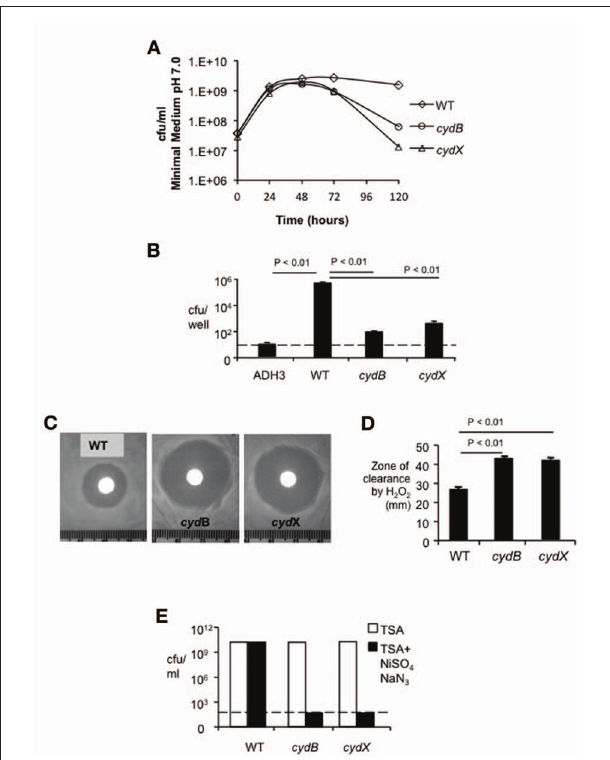
FIGURE 2 | Characterization of the cyd X mutant. (A) Loss of viability in stationary phase. Growth kinetics of B. abortus in modified E medium pH 7.0 was monitored by CFU counting at each indicated time point. Each data point represents results of a single assay that was repeated twice. (B) Intracellular survival of the cydX mutant in J774 macrophages. Strain ADH3 ( virB2 ) served as an attenuated control. Data are represented as the mean ± standard deviation (SD) of triplicate samples from one assay that was repeated twice with the same result. Significance of differences was analyzed by One-Way analysis of variance (ANOVA), with a P value of less than 0.05 considered as significant. The dotted line indicates the limit of detection. (C and D) Sensitivity to hydrogen peroxide. Log-phase bacteria were plated on TSA and oxidative killing was determined by measuring the diameter of clear zone surrounding a paper disk soaked with 5 μ l of 30% hydrogen peroxide. Large zones of bacterial growth inhibition were observed in both cydX and cydB mutants (Typical photographs were shown). Data in (D) are represented as means of a single assay with five samples ± SD, that was repeated once with the same result. Significance of differences was analyzed by One-Way ANOVA, with P values for pairwise comparisons with P < 0 . 05 indicated. (E) Sensitivity to sodium azide plus nickel sulfate. Log-phase bacteria growing TSA or TSA supplemented with 0.15mM NiSO 4 and 0.15mM NaN 3 were serially diluted and were plated on TSA for enumeration of surviving bacteria. Survival of treatment with sodium azide plus nickel sulfate was calculated as the ratio of CFU on TSA + NiSO 4 /NaN 3 to CFU on TSA. While these ratios were approximately 1 for wild type B. abortus , neither cydX mutant nor the cydB mutant survived in the presence of these chemicals. A dotted line indicates the limit of detection of this assay.